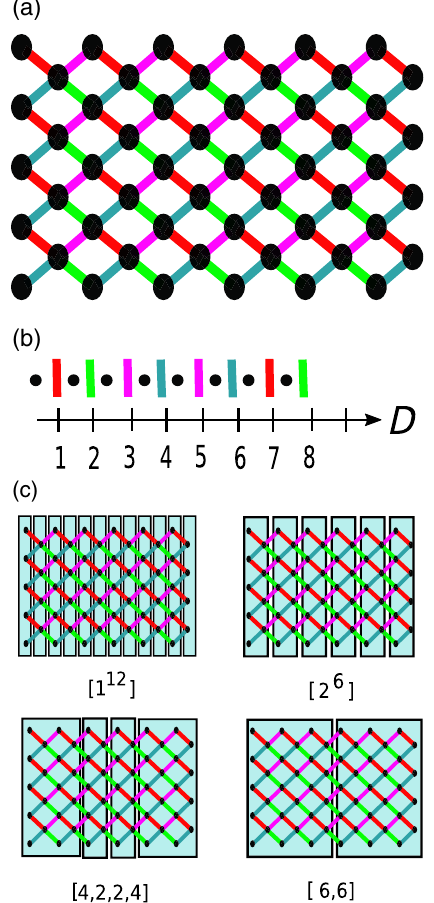
FIG. 12. (a) Sketch of the quantum circuit with 54 qubits in a 2D grid. The qubits are represented by the black dots while the 2-qubit gates by the color links. (b) The circuit alternates 1-qubit gates (black dots) with 2-qubit gates (here the control- Z gate). The depth D counts the number of 2-qubit gates per qubit. (c) Different grouping strategies for the group MPS algorithm. ½ 1 12 (cid:3) corresponds to a grouping in 12 blocks counting 1 column each; ½ 4 ; 2 ; 2 ; 4 (cid:3) corresponds to a grouping in 4 blocks counting, respectively, 4, 2, 2, and 4 columns.